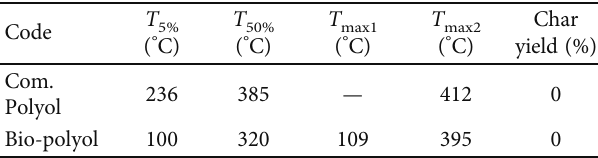
Table 3: Summary of TGA results for